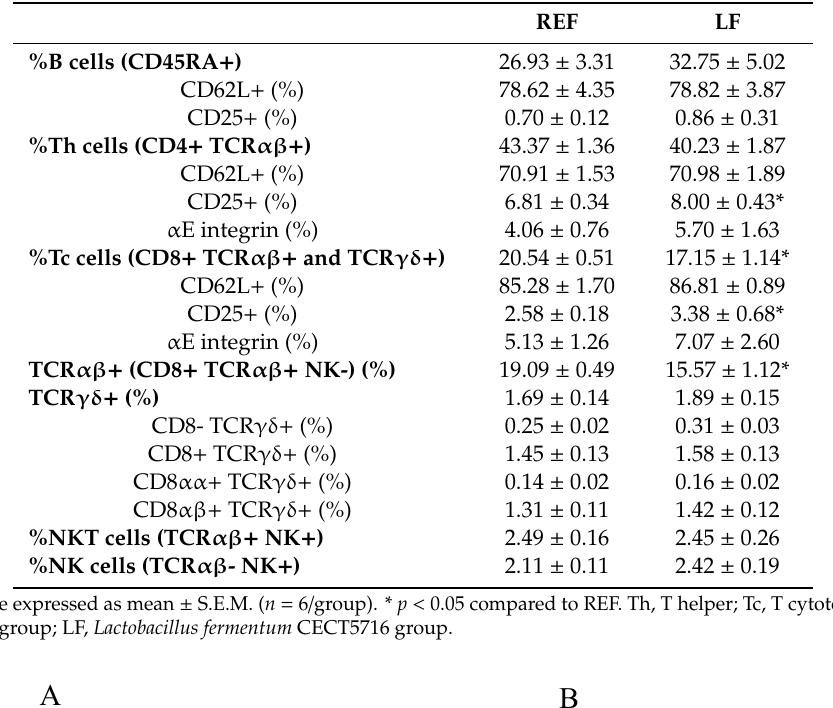
Table 3. Characterization of mesenteric lymph node cells phenotype of dams.